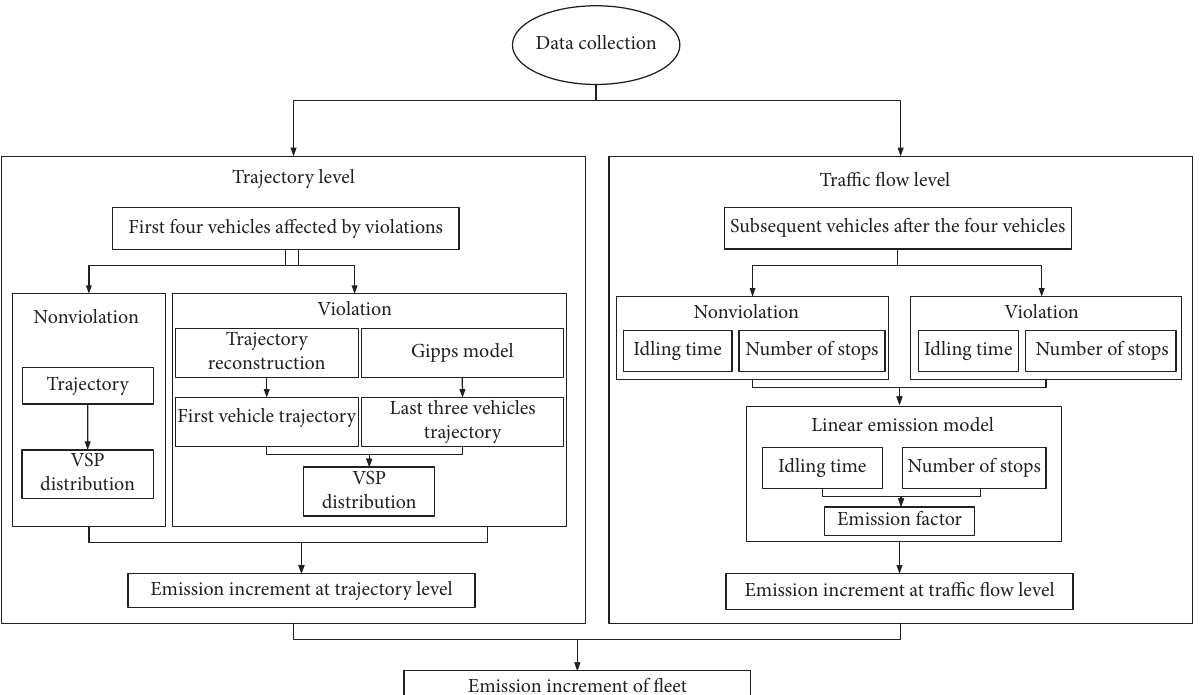
Figure 2: Overview of the